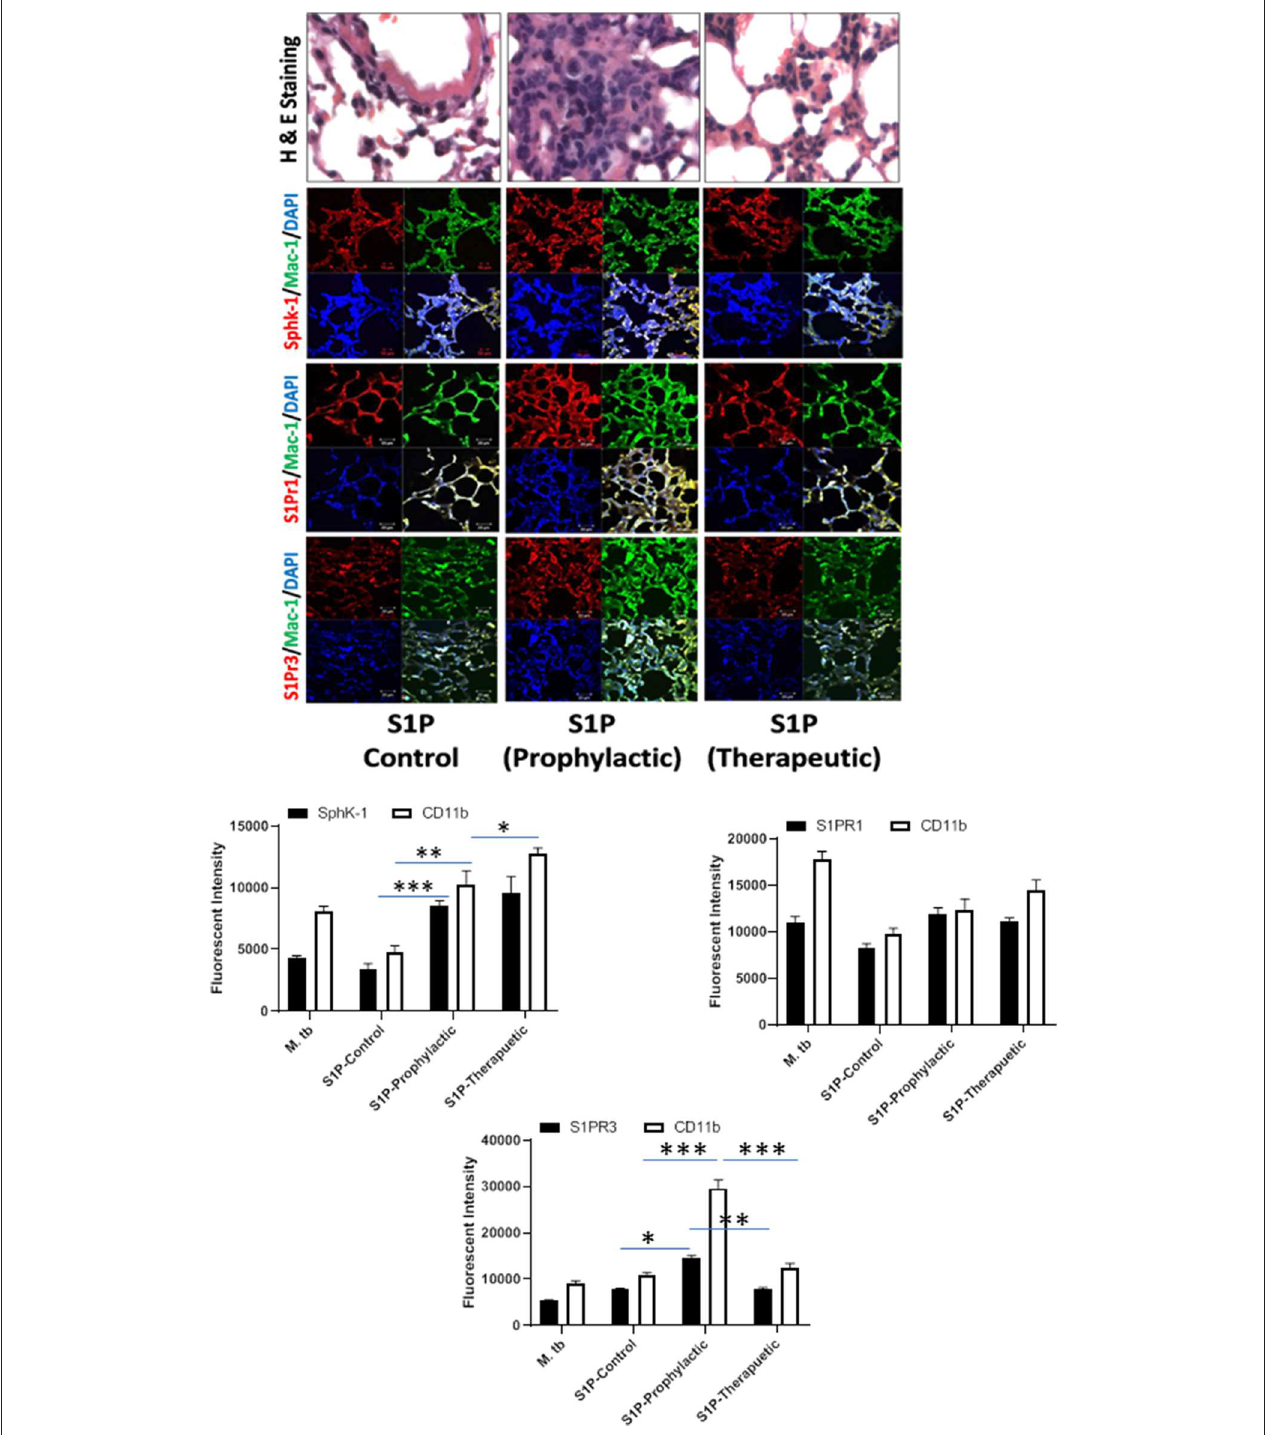
FIGURE 6 | Sphingolipids modulate macrophage infiltration and pro-inflammatory response in M. tuberculosis –challenged animals. The infected mice were treated with sphingosine-1-phosphate (S-1P) as per Figure 3A , and cryosections of lung from these mice were analyzed for expression of S-1PR1, S-1PR3, and SphK-1 and infiltration of CD11b + macrophages by confocal microscopy. Shown here is the representative images of mouse lung from each group. Mean fluorescence intensities of Sphk-1, S-1PR1, and S-1PR3 expression were plotted against Mac1 expression. Statistical analyses were conducted using two-way ANOVA followed by Bonferroni posttest (* P < 0.05, ** P < 0.01, *** P < 0.001).